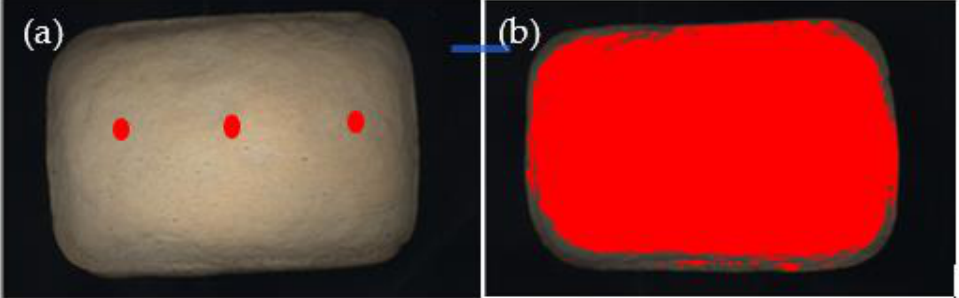
Figure 1. Bread surface area evaluation by colorimeter ( a ) and computer vision image analysis ( b ) .